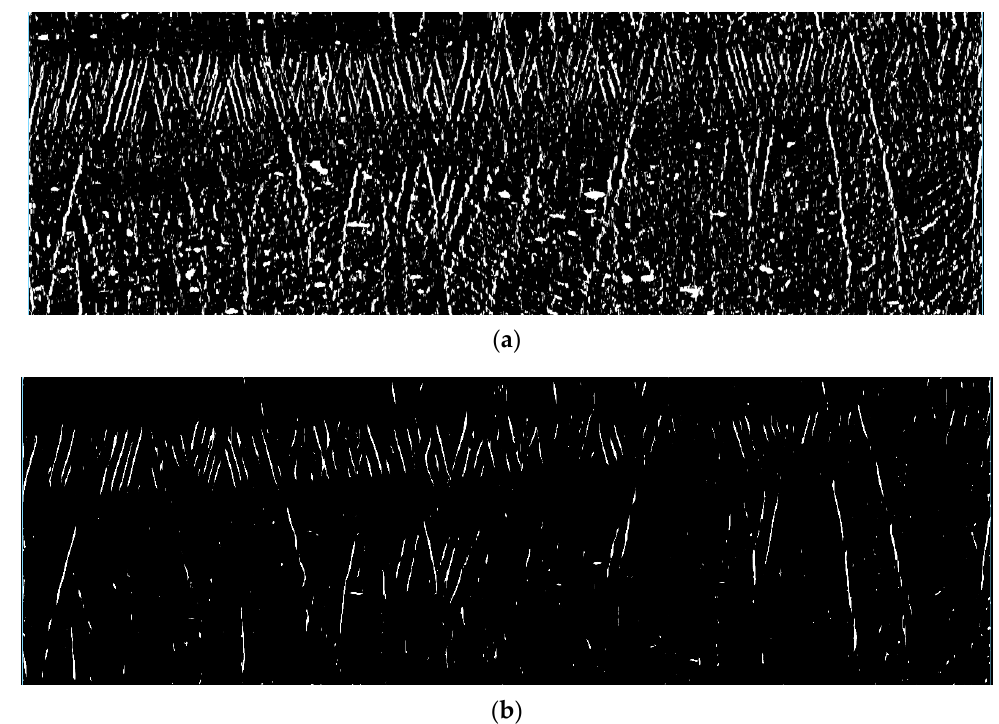
Figure 5. First edge enhancement with sequential edge evidence. When first applied along the ( a ) horizontal direction, the edges were sharper, and, when it was subsequently applied along the ( b ) vertical direction, the discontinuity was enhanced.